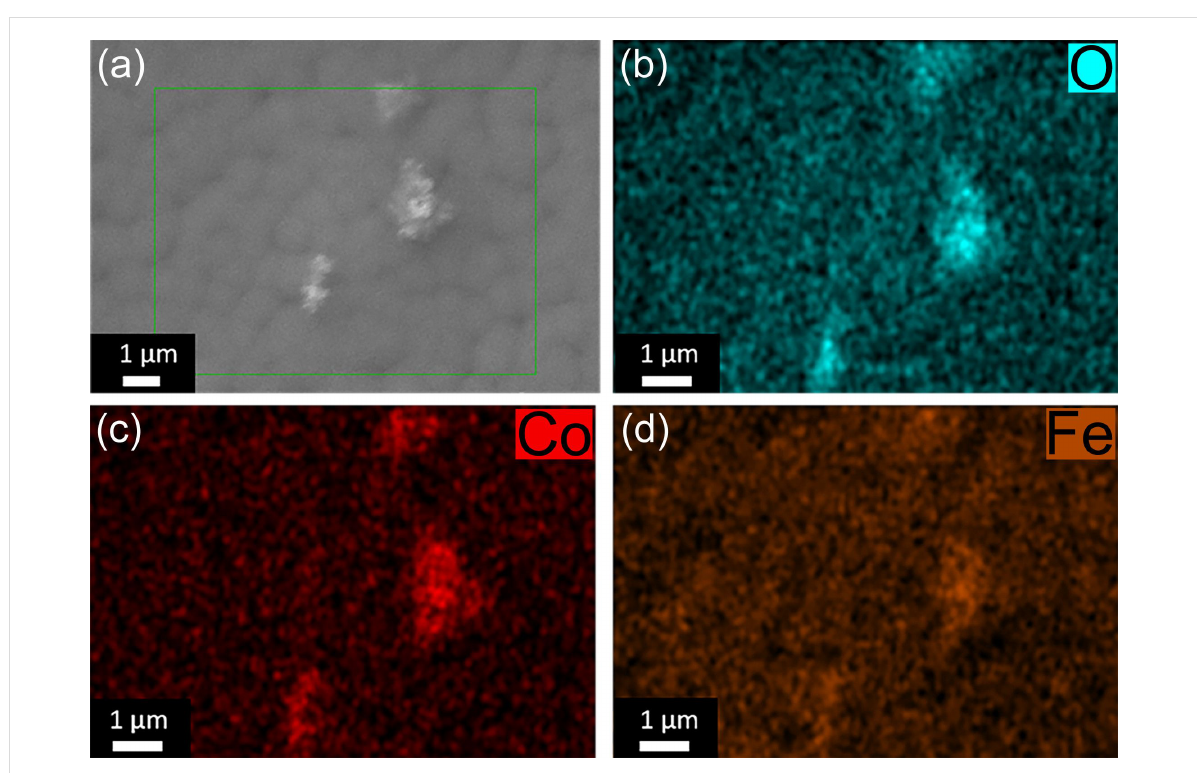
Figure 7: (a) SEM image and (b–d) EDX maps of (b) oxygen, (c) cobalt, and (d) iron of the PVDF-TrFe/CoFe 2 O 4 nanocomposite with 5 wt % of CoFe 2 O 4 magnetically poled at 111 mT for 1 h at 65